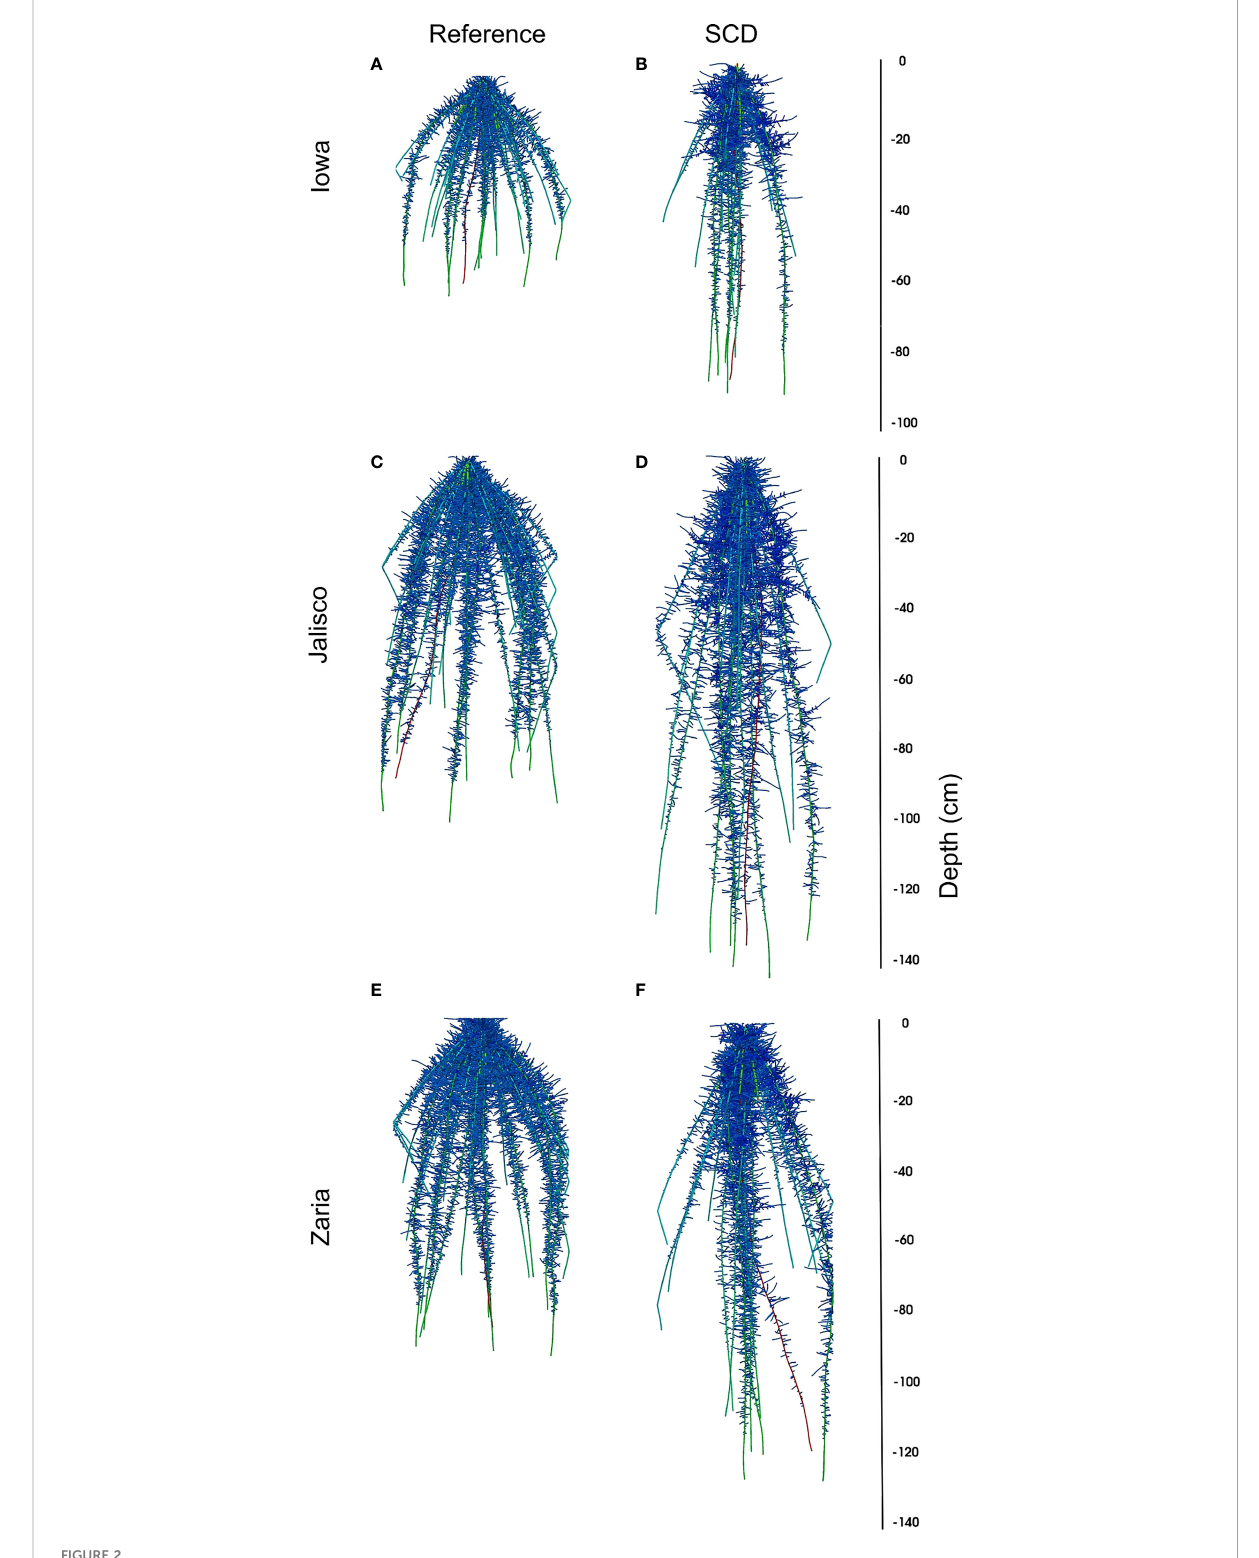
FIGURE 2 Visualization of reference (panels A, C, E ) and SCD (panels B , D, F ) maize root phenotypes in the Iowa (panels A, B ), Jalisco (panels C, D ) and Zaria (panels E, F ) environments without drought stress at 42